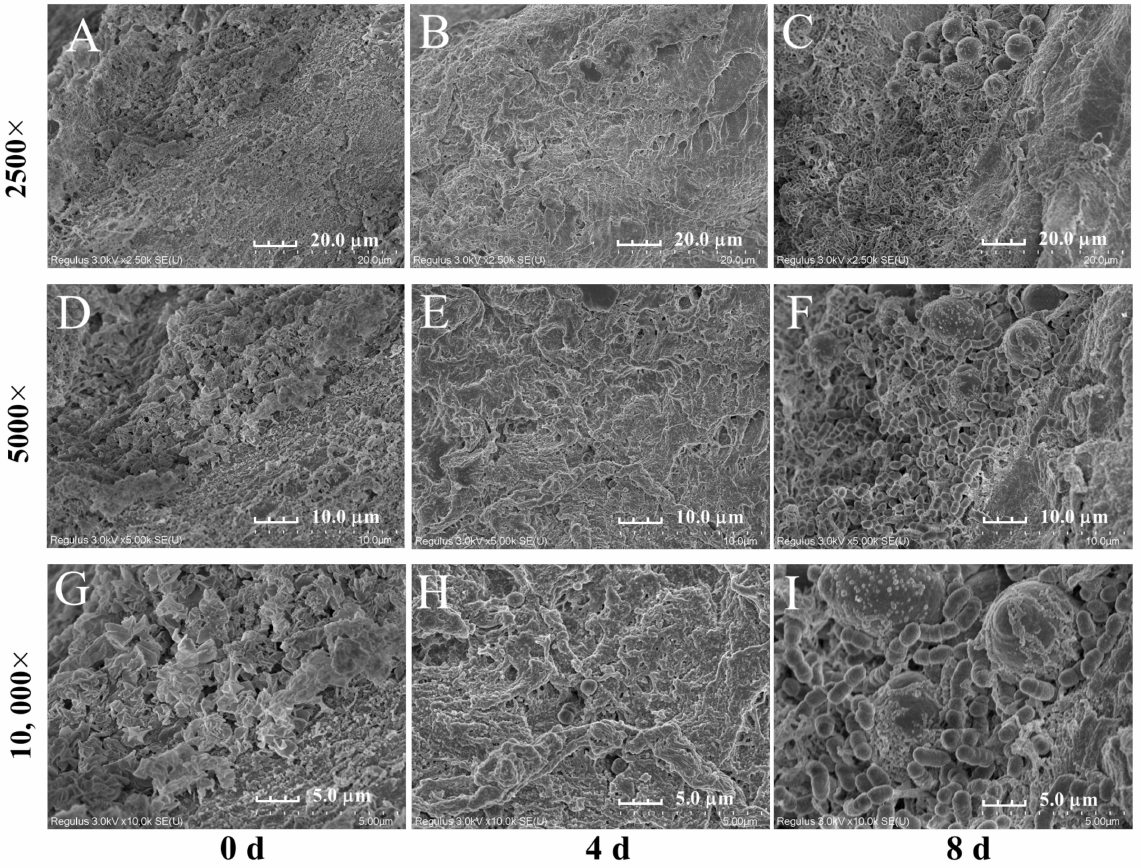
Figure 3. Scanning electron microscopes of vinasse hairtails muscle tissues with different fermentation times. At 2500 × of the fermentation early stage (0 d) ( A ), the middle stage of fermentation (4 d) ( B ), and the late stage of fermentation (8 d) ( C ); at 5000 × of 0 d ( D ), 4 d ( E ), and 8 d ( F ); at 10,000 × of 0 d ( G ), 4 d ( H ), and 8 d ( I